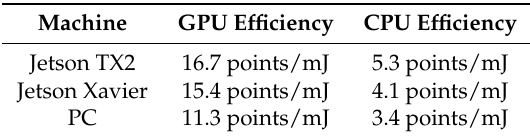
Table 5. Power efficiency of each device in terms of the average number of processed points per joule of consumed